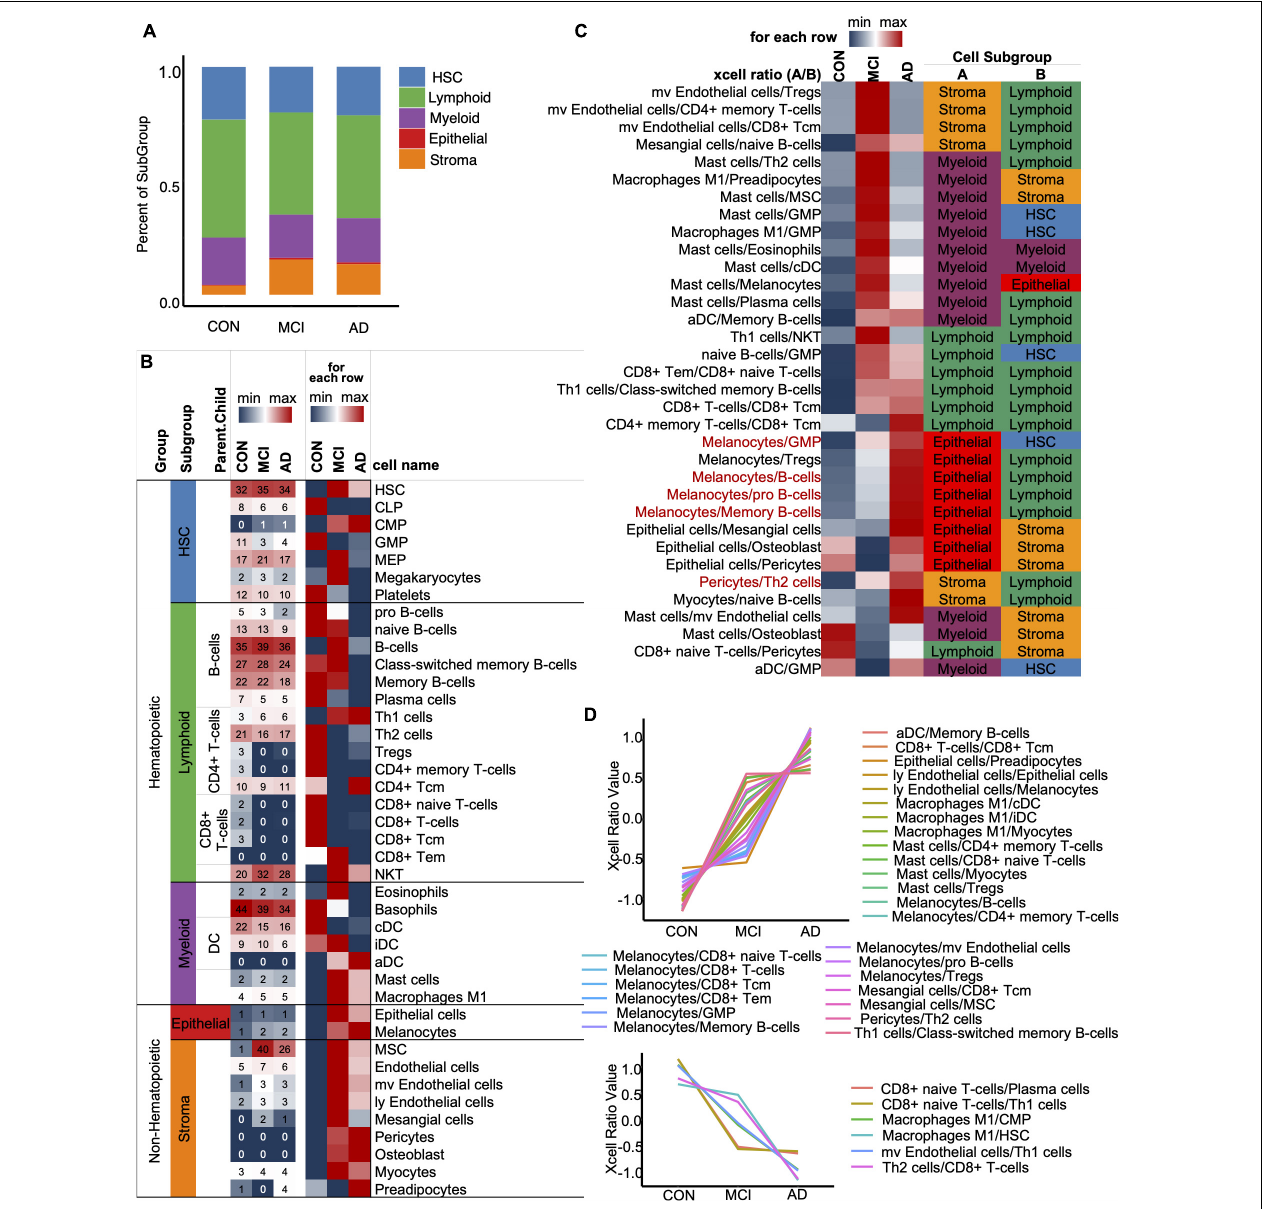
FIGURE 3 | XCell and XCell-Ratio analysis. (A) Stacked five cell types in the CON, MCI, and AD groups. (B) Representative cells from five cell types. The number is original XCell score. (C) The union set of top-10 XCell-ratios in the con, MCI, and AD groups. All values are normalized by row. Red items, non-Hematopoietic/Hematopoietic items show a gradual trend with AD progression. (D) Cell ratios show a gradual trend with AD progression.